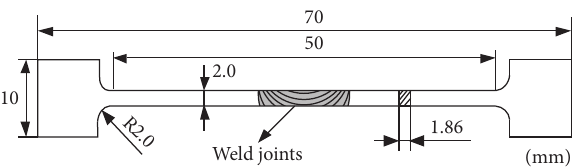
Figure 2: Schematic illustration of the transverse tensile sample.